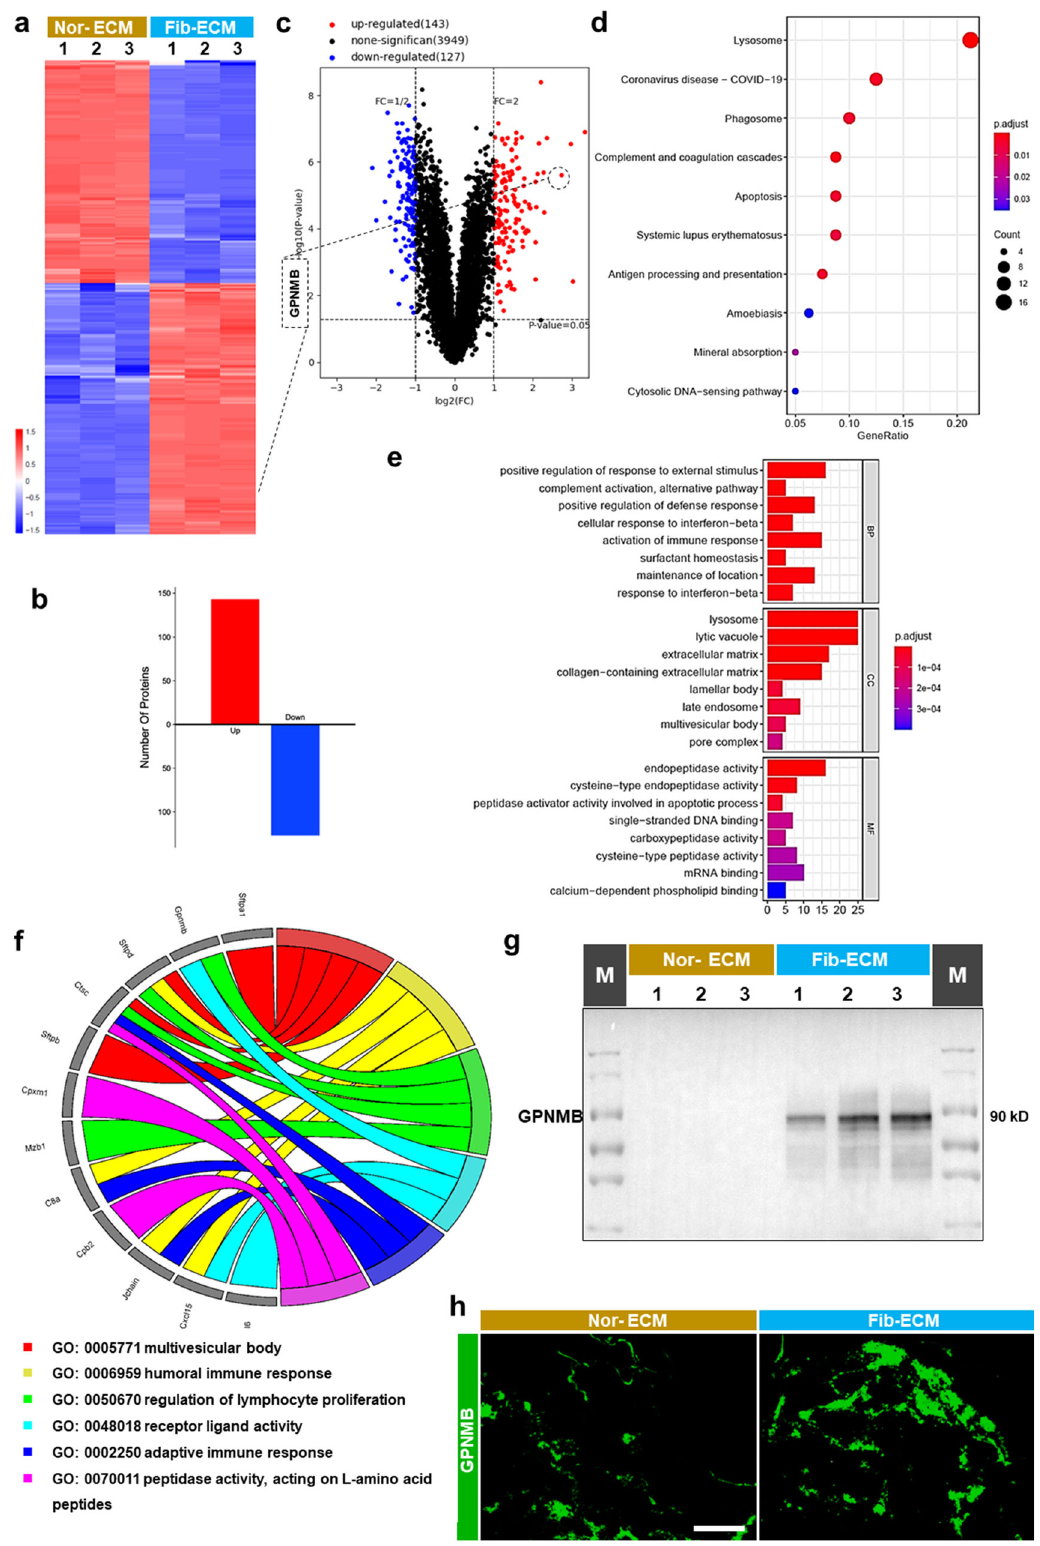
Fig. 2 GPNMB protein level increased obviously in fi brotic ECM. a – c Proteomics analysis showed obvious changes in the expression of ECM components with |log2(fc)|> 1 ( p < 0.05) in mice from the two groups ( n = 3 animals). d – f KEGG pathway analysis and GO enrichment analysis of the identi fi ed upregulated proteins. g Representative Western blot showing that the GPNMB protein level was increased in the ECM of silicosis mice; n = 5 independent experiments. h Immuno fl uorescence staining was used to assess the protein levels of GPNMB in fi brotic ECM; scale bar = 200 μ m. Nor-ECM, normal ECM; Fib- ECM, fi brotic